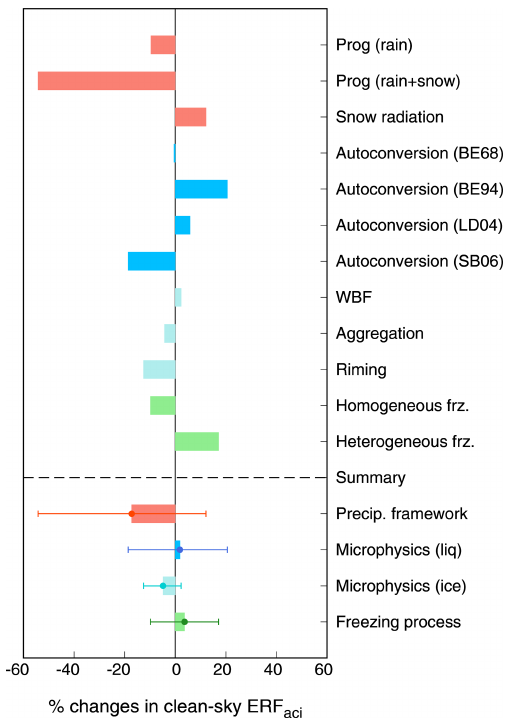
Figure 4. Percentage change of global annual mean clean-sky ERF aci in response to (red) the precipitation treatment, (blue) liq- uid microphysics, (cyan) ice microphysics, and (green) nucleation of new ice particles due to freezing. Error bars represent the mini- mum and maximum ranges for each component considered in this